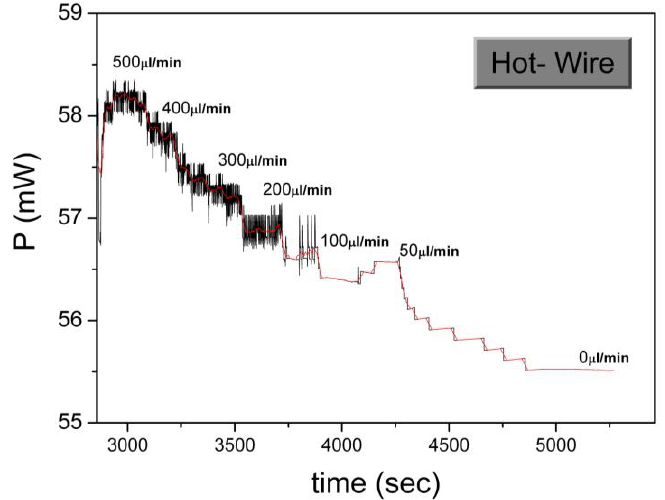
Figure 4. The sensor operation under the hot-wire principle (CT mode). The power generated at the heater for denoted flow rate values is shown. The black line represents the real time sensor signal, while the red line is derived by averaging of the results.